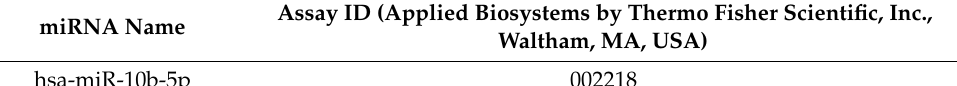
Table 1. List of assays employed for miRNA detection. Assay ID (Applied Biosystems by Thermo Fisher Scientific, miRNA Name